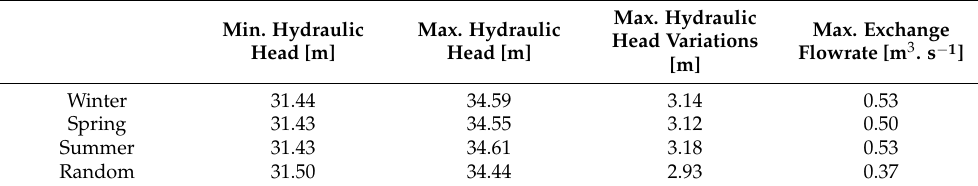
Table 3. Summary of the results concerning the quarry–groundwater interactions and hydraulic head fluctuations in the quarry during the simulations. These data concern the minimum and maximum hydraulic head in the quarry, the maximum variation in the hydraulic head in the quarry, and the maximum exchange flowrate between the quarry and the aquifer for each